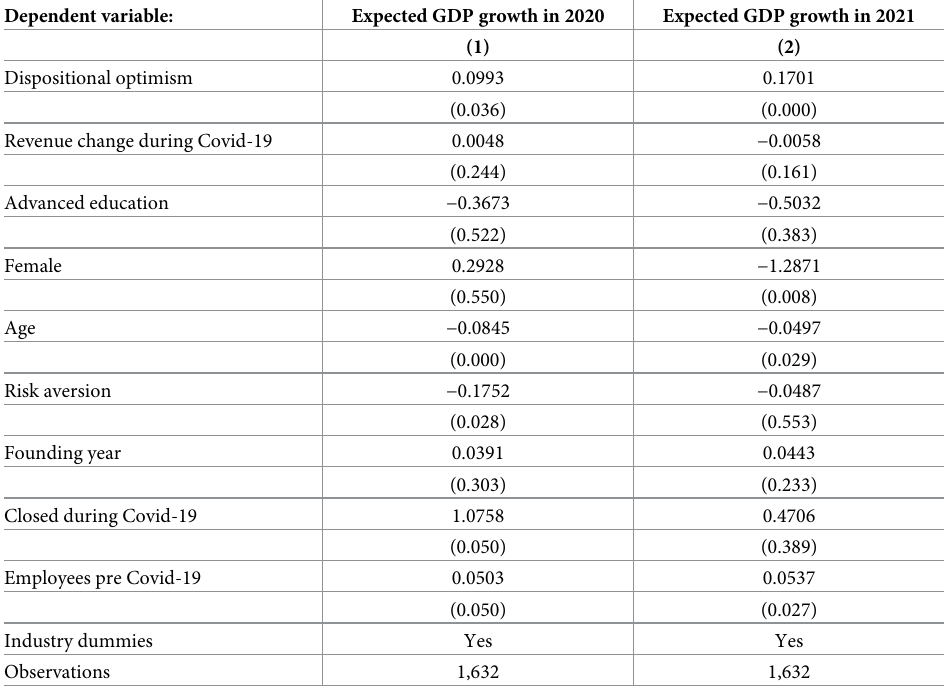
Table 6. Optimism and macroeconomic